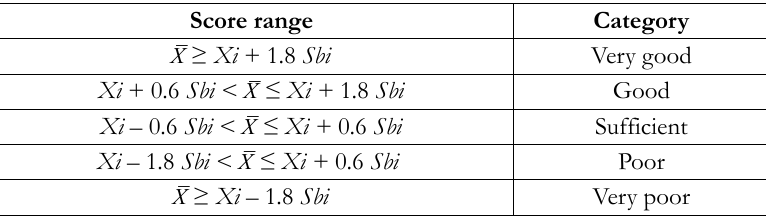
Table 2. Criteria of Sbi